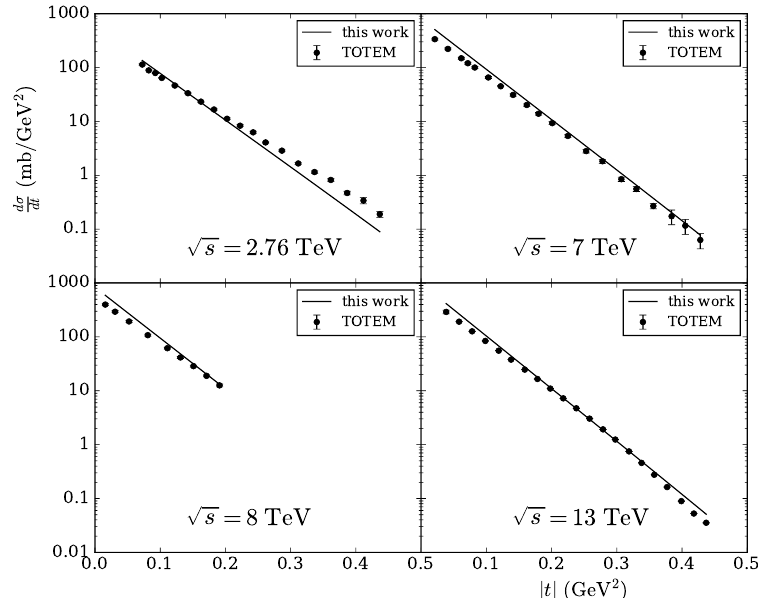
Figure 4 . The di(cid:11)erential cross section as a function of j t j . The solid lines represent our calculations obtained with the experimental data measured by the TOTEM collaboration in the range, 2 : 76 (cid:20) p s (cid:20) 13 TeV. The data are depicted with their errors.